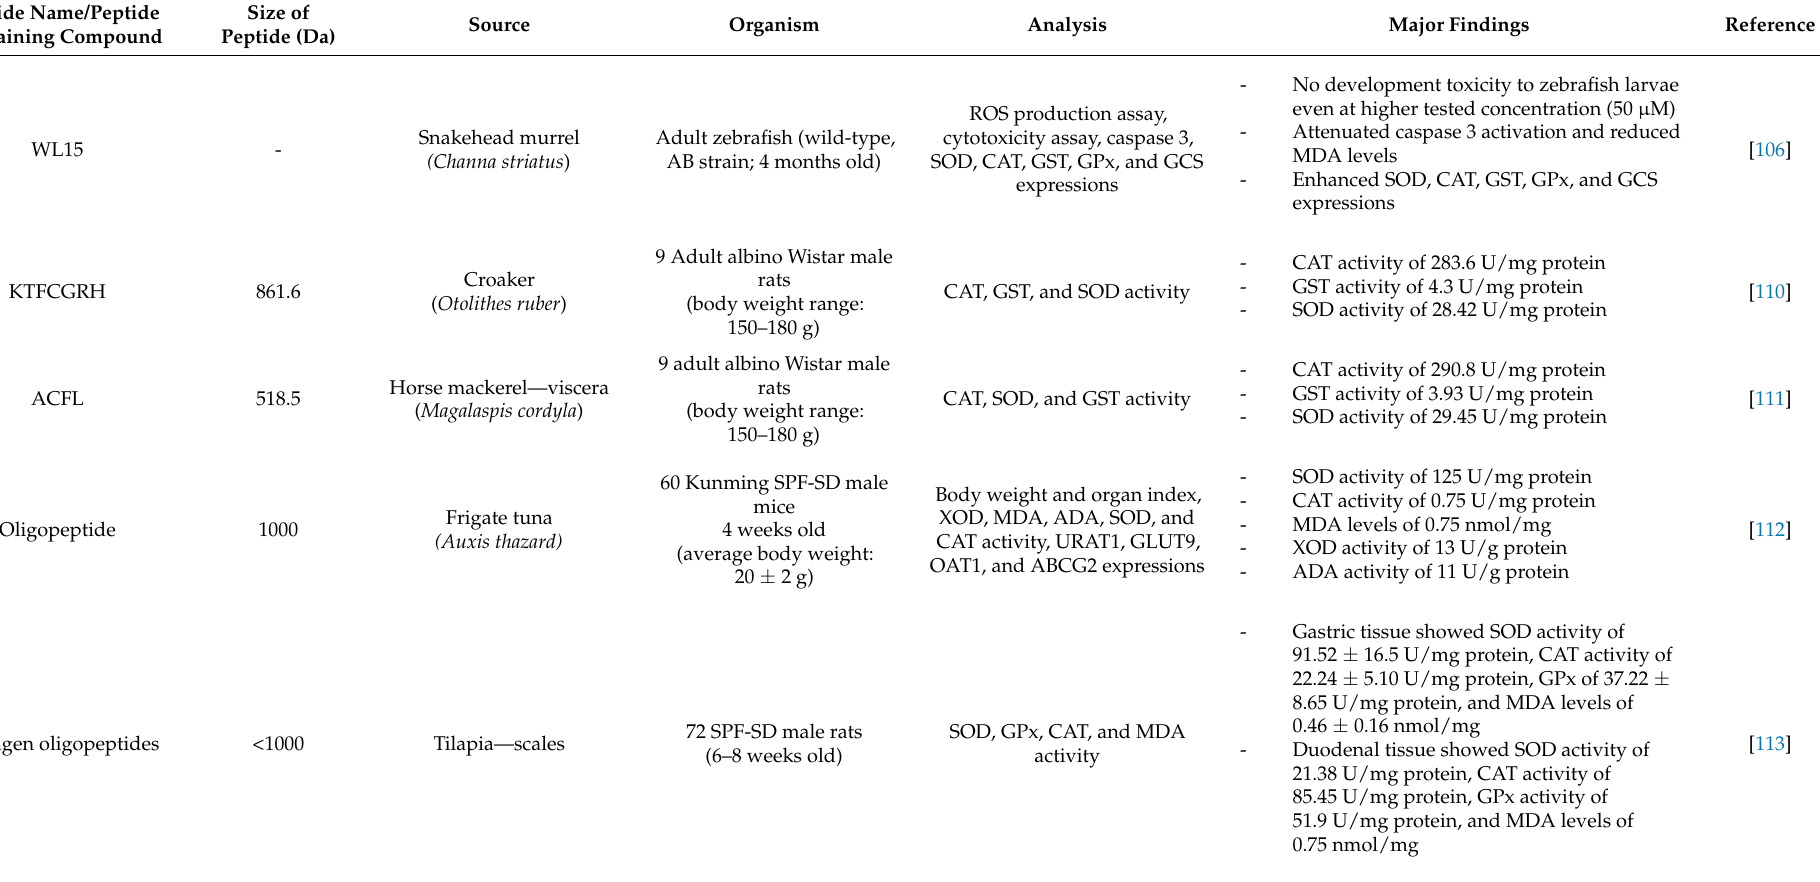
Table 2. Antioxidant effects of bioactive peptides from marine animals—in vivo